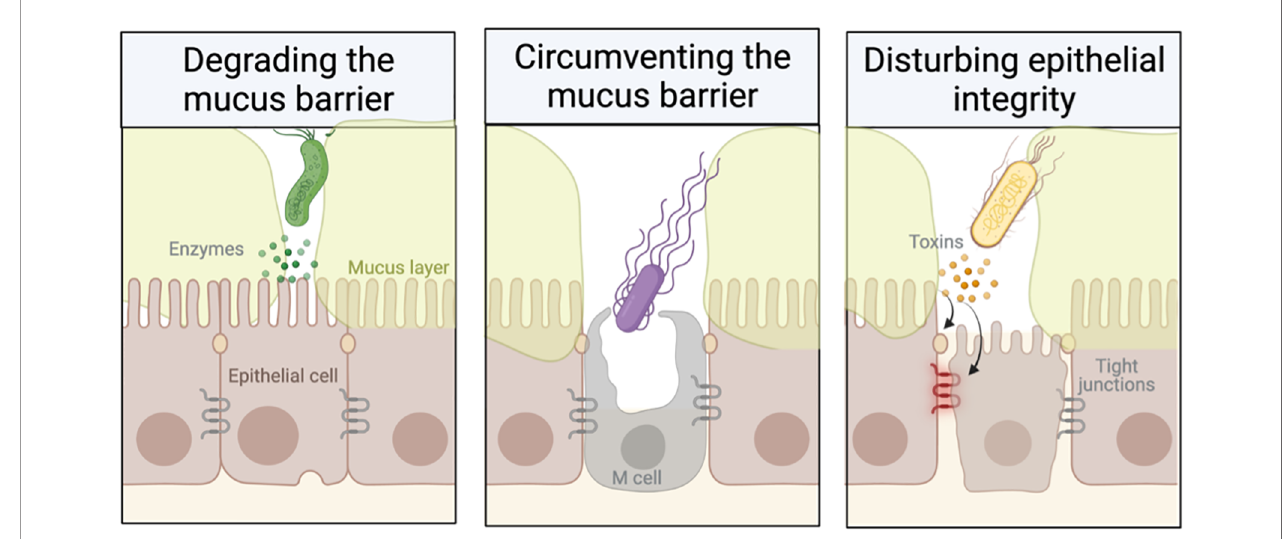
FIGURE 2 | Strategies employed by pathogens to overcome the mucus barrier (created with